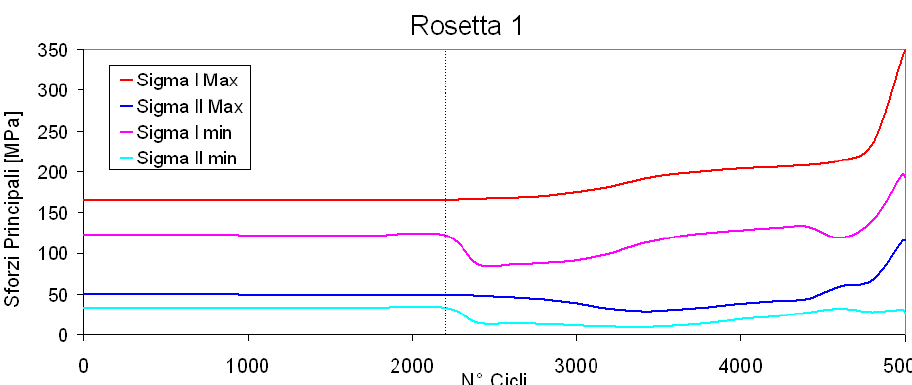
Figura 24: Andamento degli sforzi principali in funzione del n° di cicli ricavati dalle deformazioni misurate durante il primo test in prossimità dell’apice criccato del danneggiamento: si nota un notevole incremento dello sforzo durante il 3° spettro caratterizzato dal minimo rapporto R